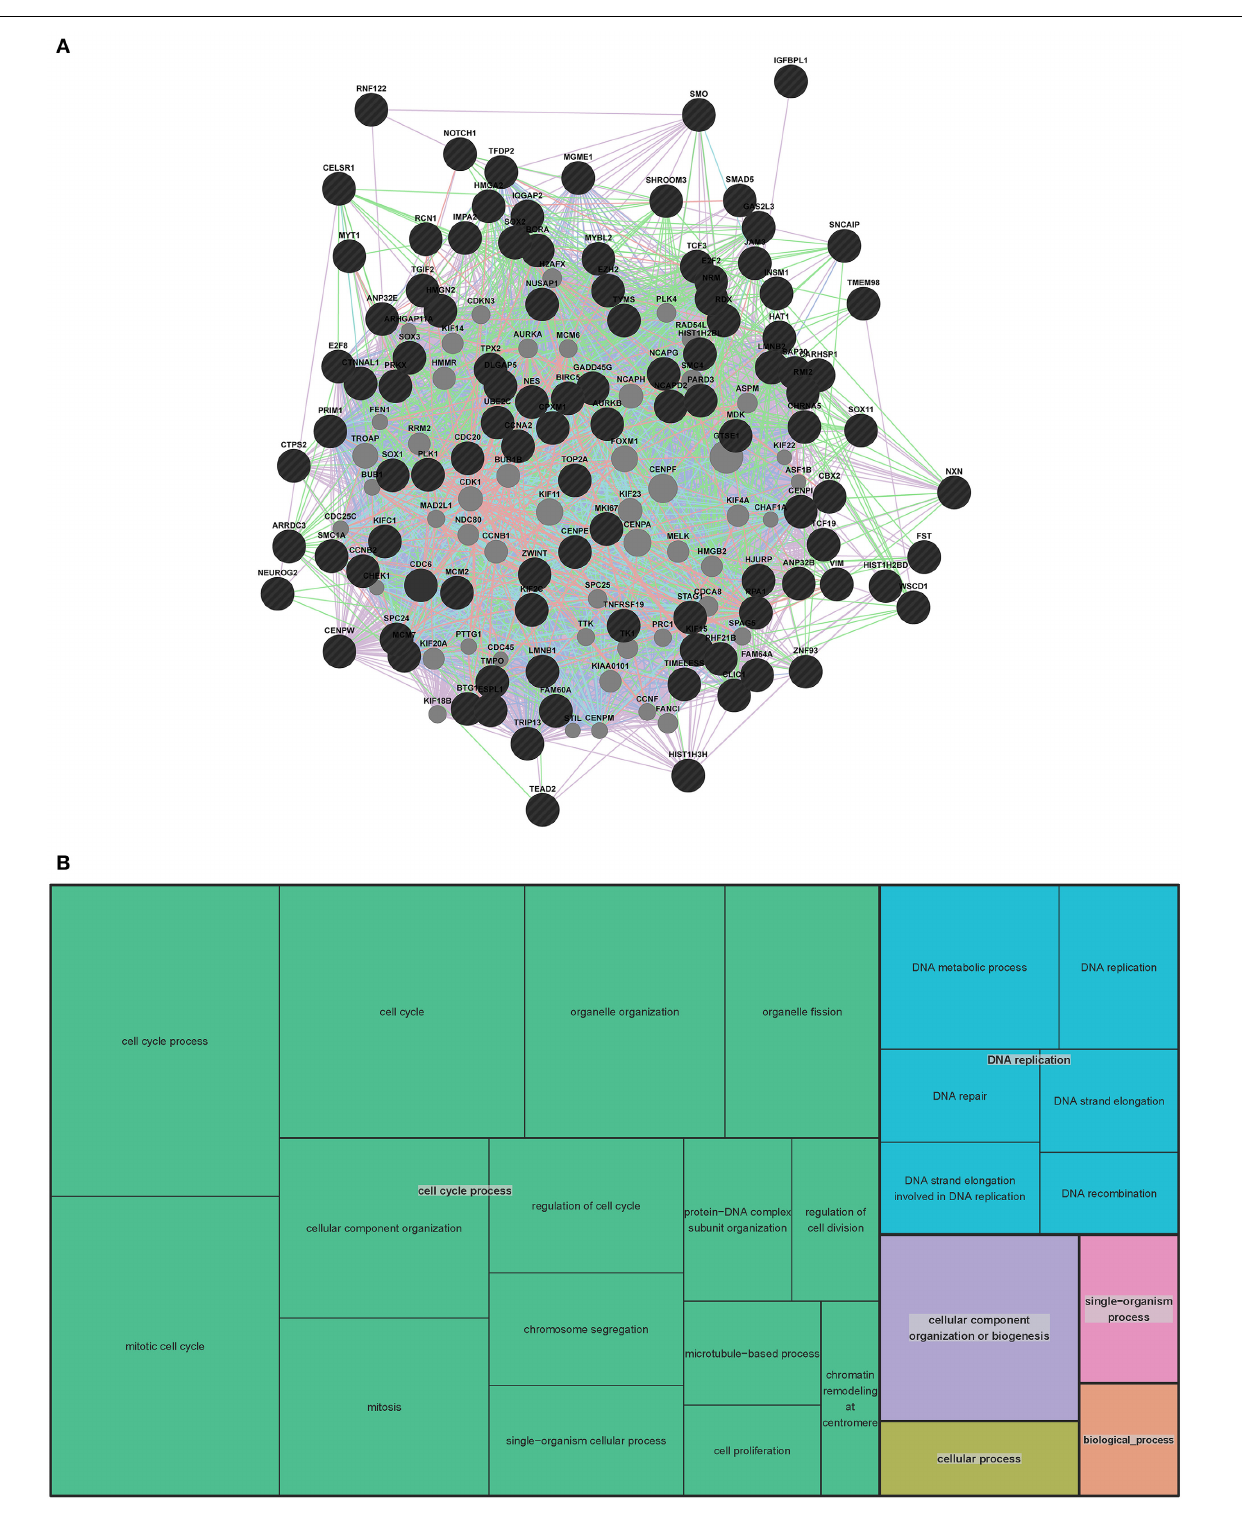
genes are shown in the network. Black circles indicate the genes that were searched through GeneMANIA and the gray circles are associated genes. The edges are indicated by associations found through co-expression (purple lines), co-localization (blue lines), physical interaction (pink lines) and shared